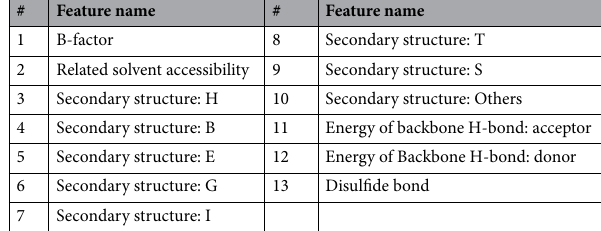
Table 3. List of descriptors in the structure-based feature